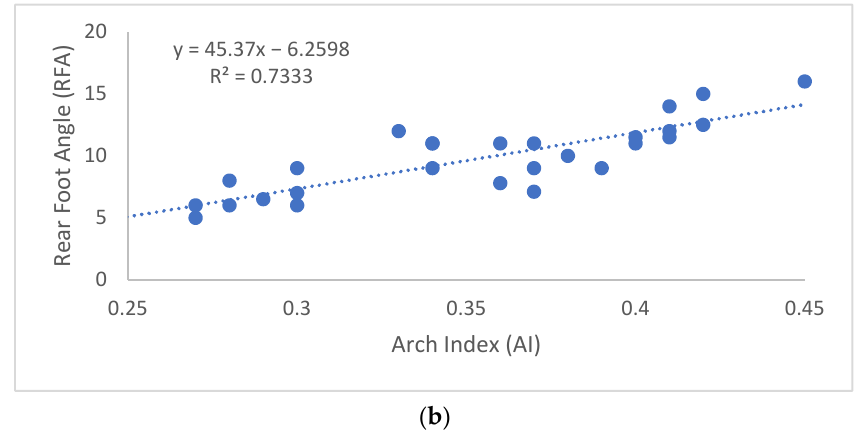
Figure 5. Relationship between Cavanagh’s AI and RFA: ( a ) left foot; ( b ) right foot. The AI range of the measurement results differs slightly from the highest and the lowest. Thus, the value of RFA ≥ 6.3° can be used as a new diagnosis reference for flatfoot in the measurement of the RFA.